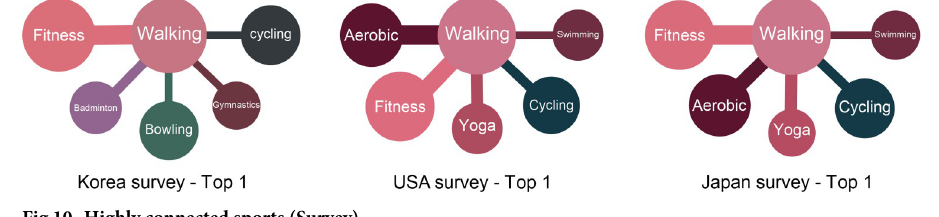
Fig 10. Highly connected sports